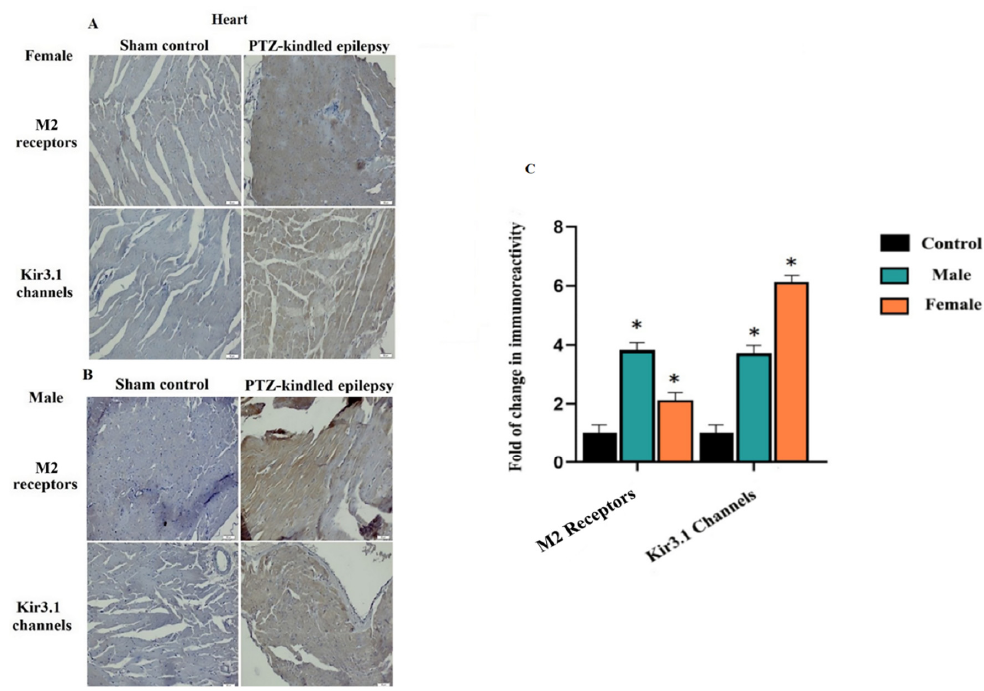
Figure 7. Examples of immunoreactivity for M2 receptors and Kir3.1 channel within the heart tissue (atria). Immunoreactivity was significantly increased for both ACh-associated centers and Kir3.1 channel, as demonstrated in the represented images. Results for female rats are demonstrated in section A , whereas for male rats they are demonstrated in section B . Pictures were taken at a magnification of ×200. Scale bar: 50 μ m. Fold change in immunoreactivity for M2 receptors and Kir3.1 channel within the heart tissue ( C ). For female PTZ-kindled rats, there was a 2.1-fold change in M2 and a 6.1-fold change in the Kir3.1 channel when compared to the controls. On the other hand, for male PTZ-kindled rats, there was a 3.8-fold change in M2 receptors and a 3.7-fold change in the Kir3.1 channel when compared to the controls, * p < 0.05.